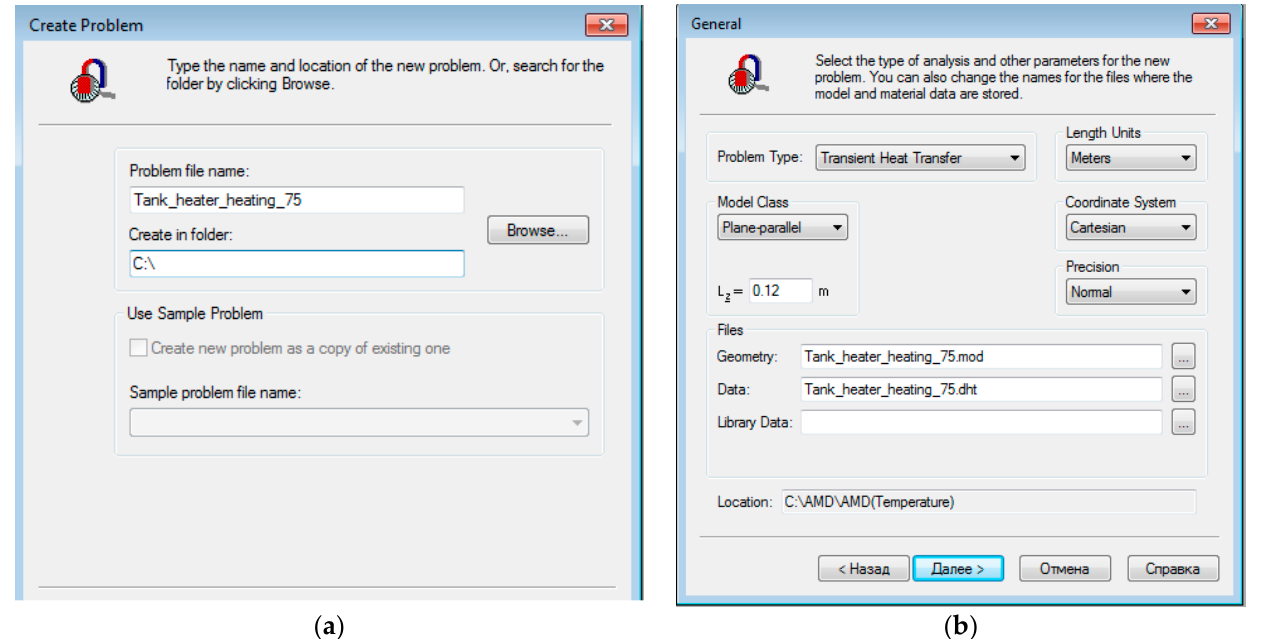
Figure 4. Non-stationary heat transfer problem with convection boundary conditions: ( a ) set-up of the name and location of the new problem, and ( b ) the type of analysis and other parameters selection for the new problem.